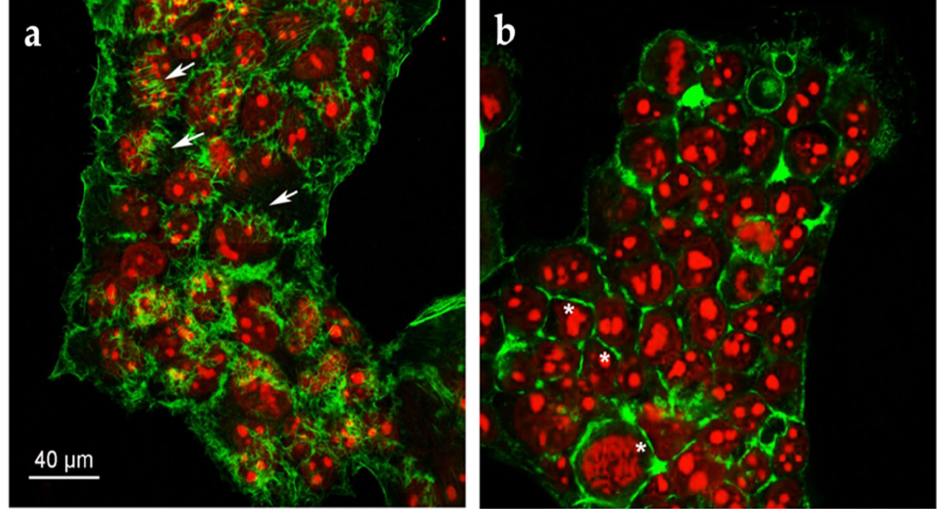
Figure 4. Representative confocal image of HepG2 cells treated with ( a ) 0.25% DMSO; ( b ) 165 µ M Quercetin for 24 h. F-actin and nuclei were stained with Phalloidin Alexa Fluor 488 and propidium iodide,